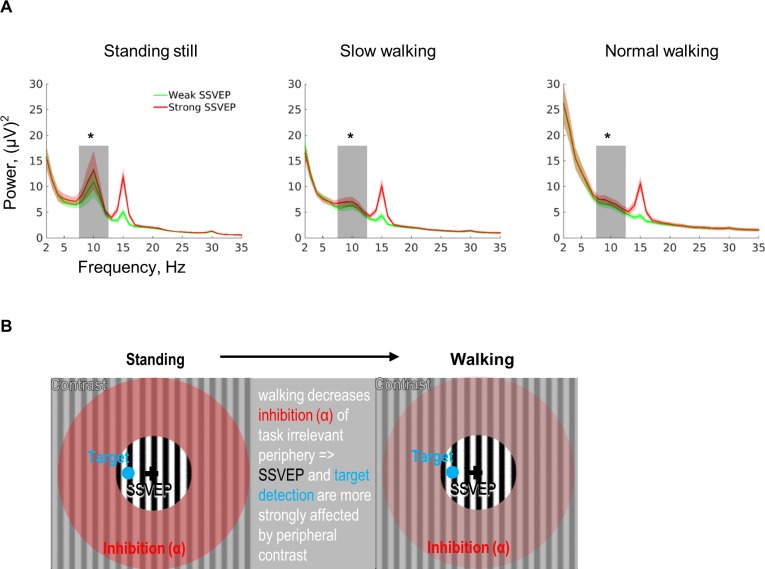
Interaction between SSVEP power and alpha power and the proposed mechanism of interaction.(A) In all three walking conditions, stronger SSVEP power was associated with stronger alpha power. No significant differences in other frequency bands were found. Shading indicates ±1 standard error. Grey bars indicate the alpha band (8–12 Hz), and asterisks indicate significant differences, n = 25 participants. (B) The diagram illustrates the suggested mechanistic influence of walking. Compared to standing still, walking leads to a decrease in inhibition indicated by alpha power (red area). This decreased inhibition gives a processing advantage to the peripheral visual field. In our specific stimulus, the peripheral visual field inhibits the central area (the strength depends on the background contrast). If the periphery is processed more strongly, the contrast of the background poses stronger influence on the central area. Consequently, SSVEP and behavioural detection rate (both exclusively probed and introduced in the central part of the visual field marked by the black circle) will decrease. The original data are available from https://doi.org/10.6084/m9.figshare.9094742.v1. SSVEP, steady-state visual evoked potential.